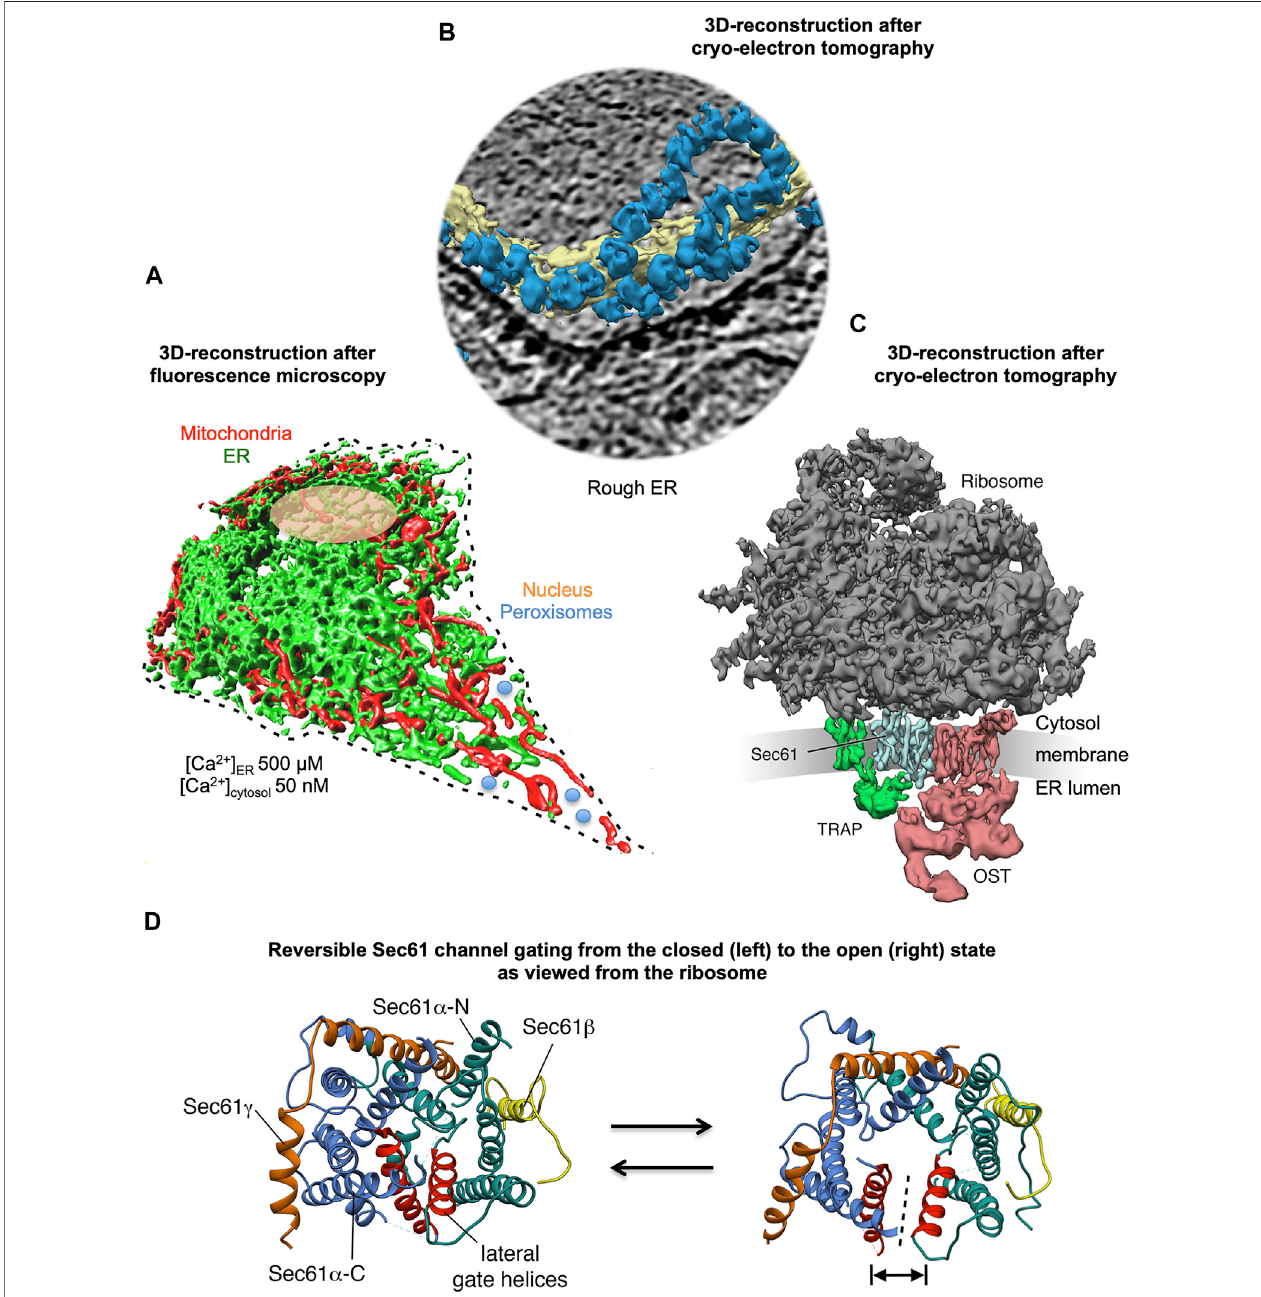
FIGURE1| 3Dreconstructionsofanucleatedmammaliancell,asectionofroughER,andaribosome-boundSec61translocon. (A) 3Dreconstructionafterlivecell fl uorescence imaging, following import of GFP into the ER and of RFP into the mitochondria. The reconstruction was arti fi cially complemented by a dashed line for the plasmamembrane,byanorangeellipseforthenucleus, andbyacoupleofbluecirclesforperoxisomes.TypicalconcentrationsoffreeCa 2+ aregivenforcytosolandER in a resting cell. (B) 3D reconstruction of cellular rough ER after CET of a slice through the respective tomogram. ER membranes are shown in yellow, 80S ribosomes in blue. (C) 3D reconstruction of the native ribosome-translocon complex in rough microsomes. The membrane density was removed for better visibility of membrane integral parts of the translocon complex. TMHs in Sec61 complex, TRAPand OST canbe distinguished. Helix 51 ofan rRNA ES and ribosomal protein eL38 representcontactsofTRAP γ ,butarehiddenbyotherribosomaldensities. (D) TheconceptofreversiblegatingoftheheterotrimericSec61complexbySPsandallosteric effectors. The Sec61 channel isshown inits modeled closed (left) and open (right) conformational states, asviewedfrom thecytosol.These twostates are suggested to beinadynamicequilibriumwitheachother.ThefullyopenstateoftheSec61channelallowstheinitialentryofprecursorpolypeptides fromthecytosolintotheERlumen andERmembrane,respectively,andisexperimentallyobservedascleavageofSPsbysignalpeptidaseonthelumenalsideoftheERmembrane.Inaddition,itallowsthe passive ef fl ux of Ca 2+ from the ER lumen into the cytosol and can be observed in live cell Ca 2+ imaging in cytosol and ER lumen (Erdmann et al., 2011; Schäuble et al., 2012).Ca 2+ ef fl ux mayalso bepossible intheexpectedtransition state(not shown),which maybe identical tothe so-calledprimedstate andisinducedbyribosomes in cotranslational- and by Sec62/Sec63 in posttranslational-transport. The Figure and Figure legend were adapted from Sicking et al. (2021a).